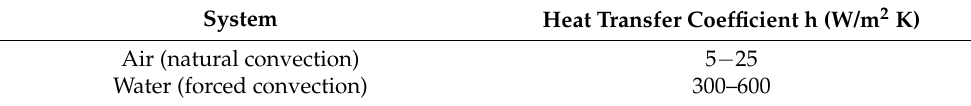
Table 1. Typical values for the convective heat transfer coefficient in water and in air.